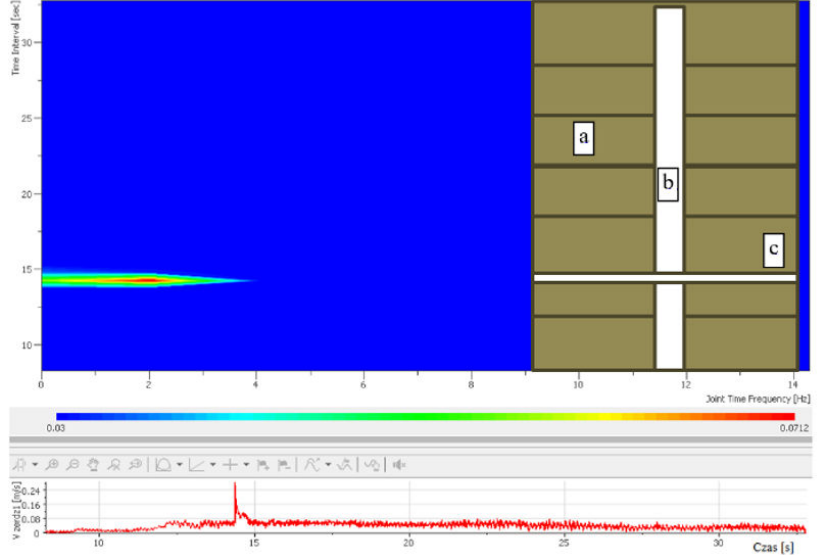
Figure 19. The detected signal on the recorded spectrogram corresponding to the location the critical discontinuity for borehole 1, rod 1—Hanning window, time domain sieve line set to 50, amplitude level display > 0.03; a, rock layer; b, borehole; c,